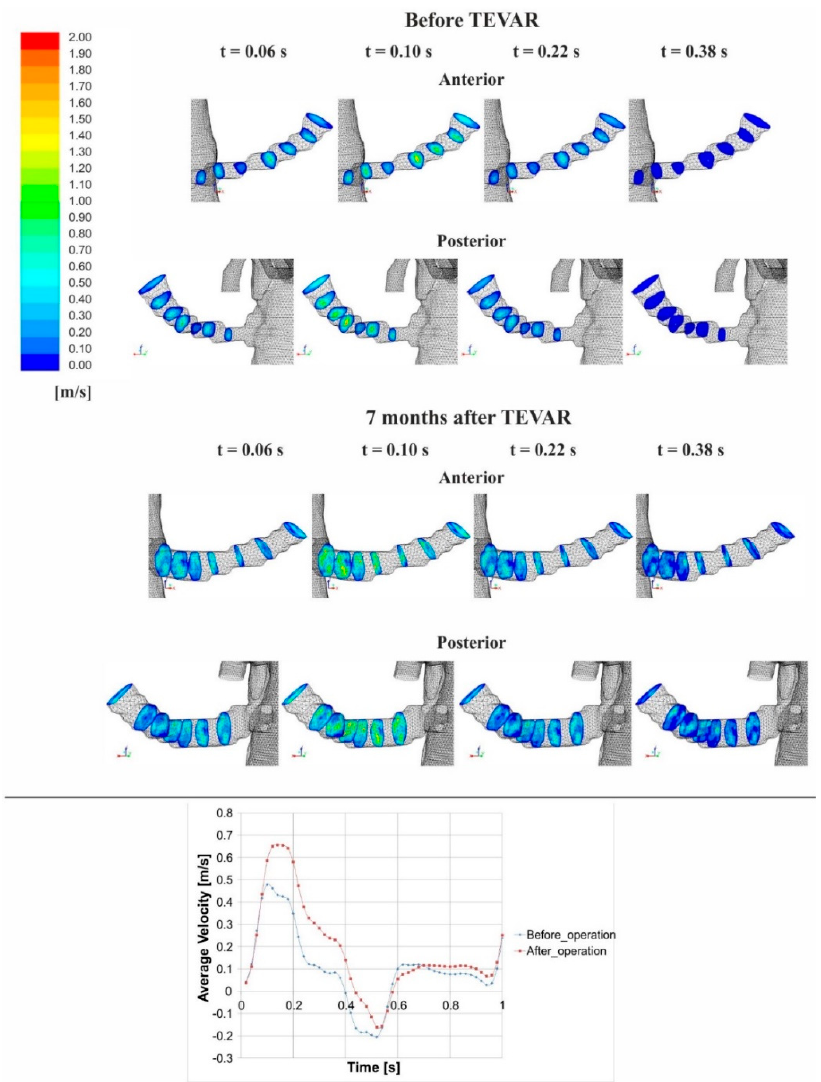
Figure 3. Changes in blood velocity contours of the left renal artery for a representative patient. ( top ): velocity contour distribution in the left renal artery for representative time points before and 7 months after TEVAR; ( bottom ): the average velocity changes in the left renal artery for one cardiac cycle. Changes in velocity contours were presented for the anterior and posterior position in the left renal artery. Numerical simulations calculated using ANSYS FLUENT software.